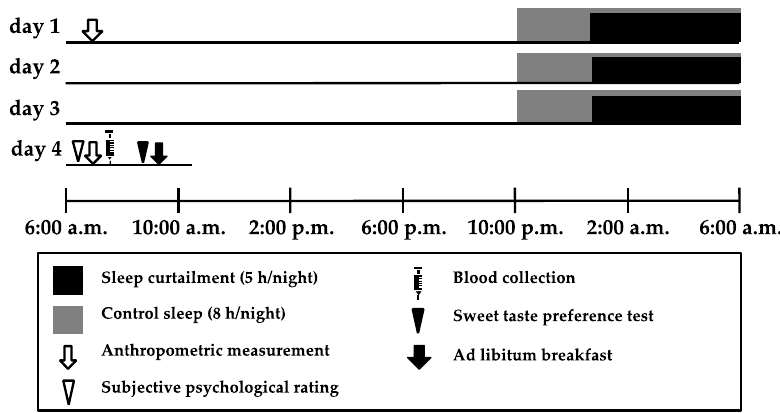
Figure 1. Experimental protocol. The protocol used a randomized crossover design with a sleep curtailment condition (5 h/night) and a control sleep condition (8 h/night). Both conditions were curtailment condition (5 h / night) and a control sleep condition (8 h / night). Both conditions were across